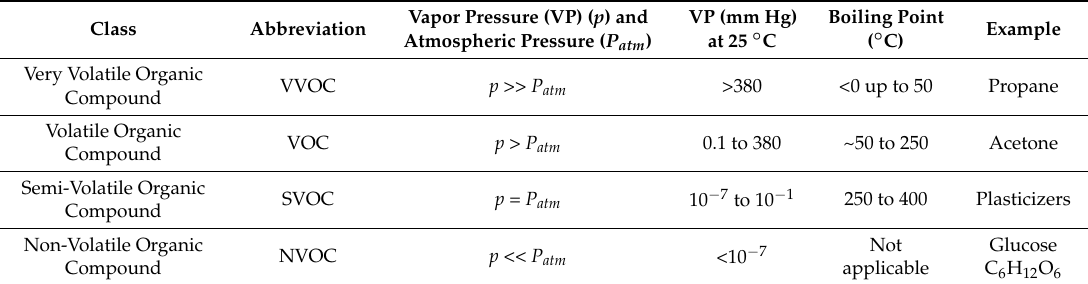
Table 1. General properties of